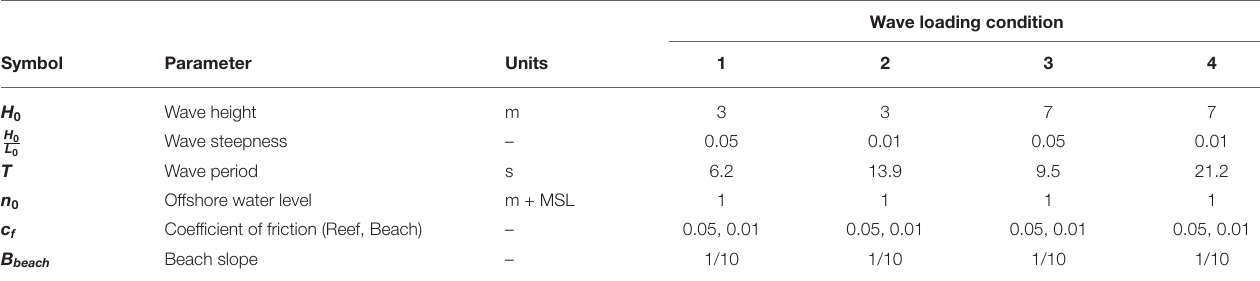
TABLE 2 | XBeach model wave loading conditions and additional reef profile